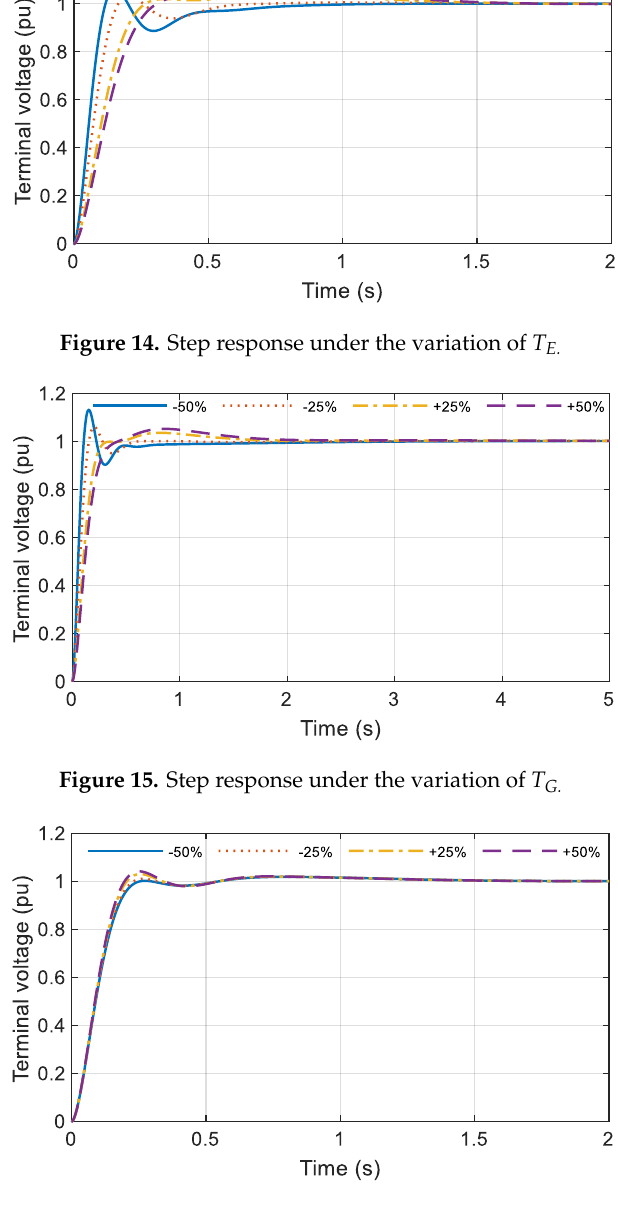
Figure 16. Step response under the variation of T S.